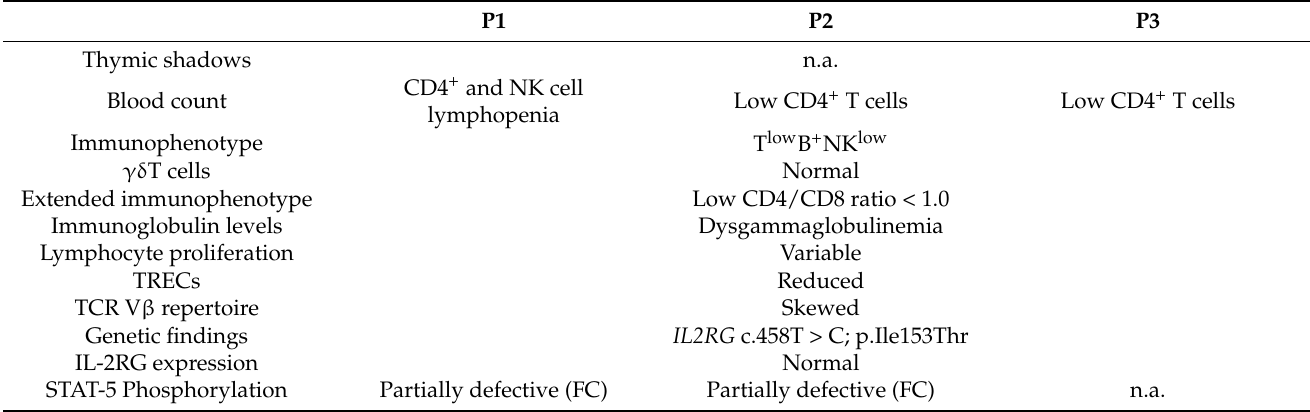
Figure S2. 3D visualization of the molecular interaction of IL-2 binding to IL-2 receptor. IL-2 is depicted in green, IL2RA in blue, IL-2RB in orange and IL-2RG in purple. Isoleucine 153